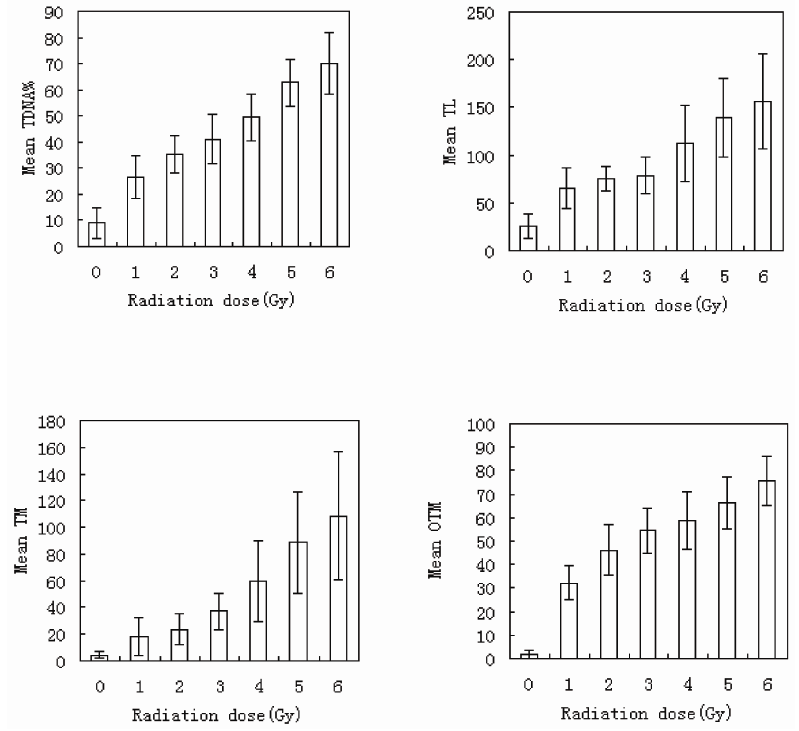
Figure 4. The column diagrams and error bars for TDNA%, TL, TM, and OTM detected immediately after irradiation by the comet assay (error bars: ±1.00 SD).